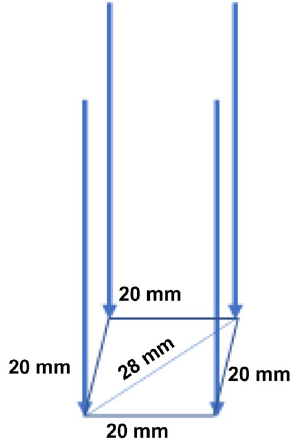
Figure 2. Geometry of four electrodes in a square.